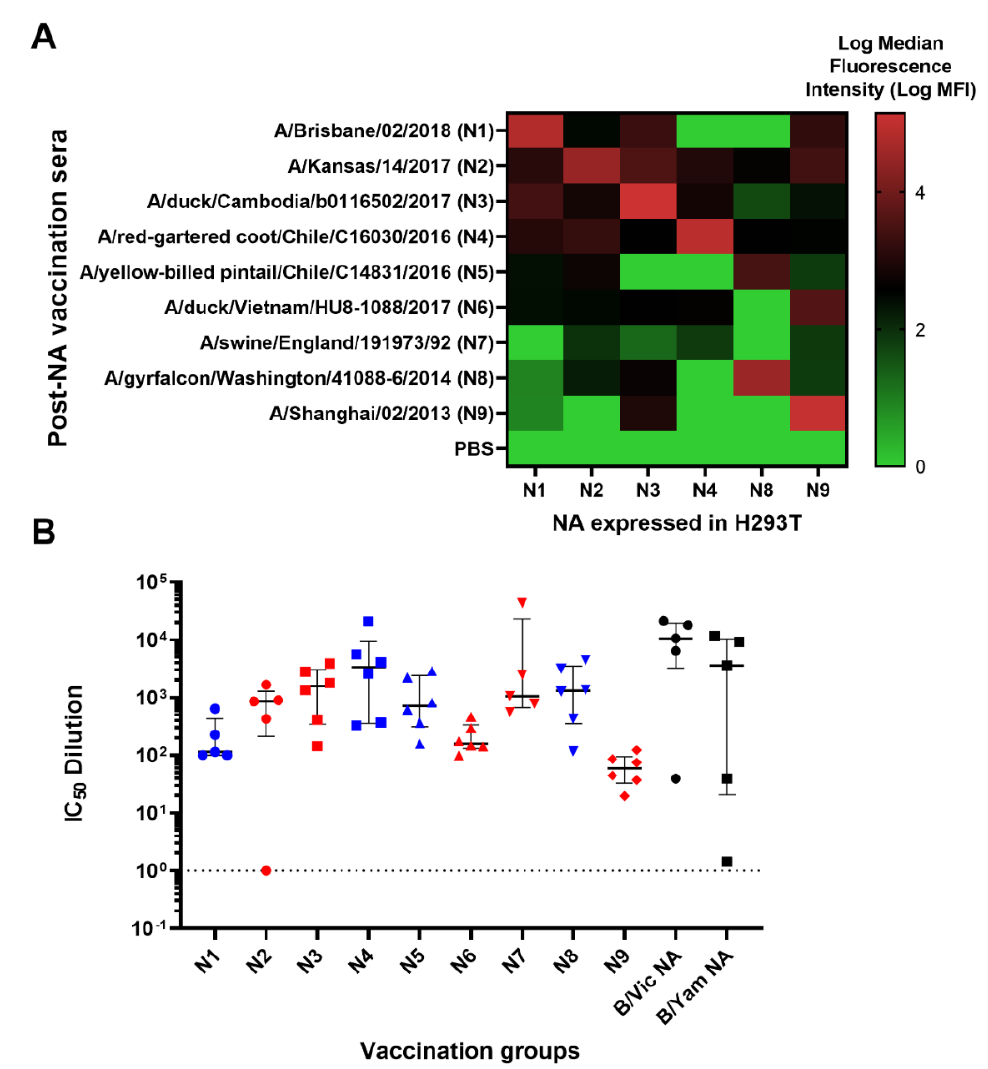
Figure 4. Binding and anti-NA activity of post-NA vaccination sera. ( A ) Binding of representative post-NA vaccination sera to HEK293T/17 transfected with pEVAC encoding homologous neuraminidase sequences of N1, N2, N3, N4, N8 and N9 was determined via FACS and reported as median fluorescence intensity (MFI) in a heatmap. Readings were performed in duplicate (n = 2). ( B ) In vitro inhibition of representative IAV (homologous subtype) and IBV (homologous lineage) pseudotypes by mouse sera vaccinated with influenza A HA from A/Brisbane/2/18 (N1), A/Kansas/14/17 (N2), A/duck/Cambodia/b0116502/17 (N3), A/chicken/NSW/1688/1997 (N4), A/yellow-billed pintail/Chile/C14831/16 (N5), A/yellow-billed teal/Chile/8/13 (N6), A/swine/England/191973/1992 (N7), A/gyrfalcon/Washington/41088-6/14 (N8) and A/Shanghai/2/13 (N9) and influenza B HA from B/Colorado/6/17 (B/Vic) and B/Phuket/3073/13 (B/Yam). Inhibition was determined via pELLA and reported as IC 50 dilution values (IC 50 is half-maximal inhibitory serum dilution). For mice vaccinated with N3-N6, N8-N9, n = 6; for N1, N2, N7 and both B lineages, n = 5. Group I NA is indicated in blue and Group II NA in red. Dashed line indicates an arbitrary IC 50 dilution value of 1 for samples that were unable to inhibit NA. Plot shows the median and interquartile range of all samples tested.